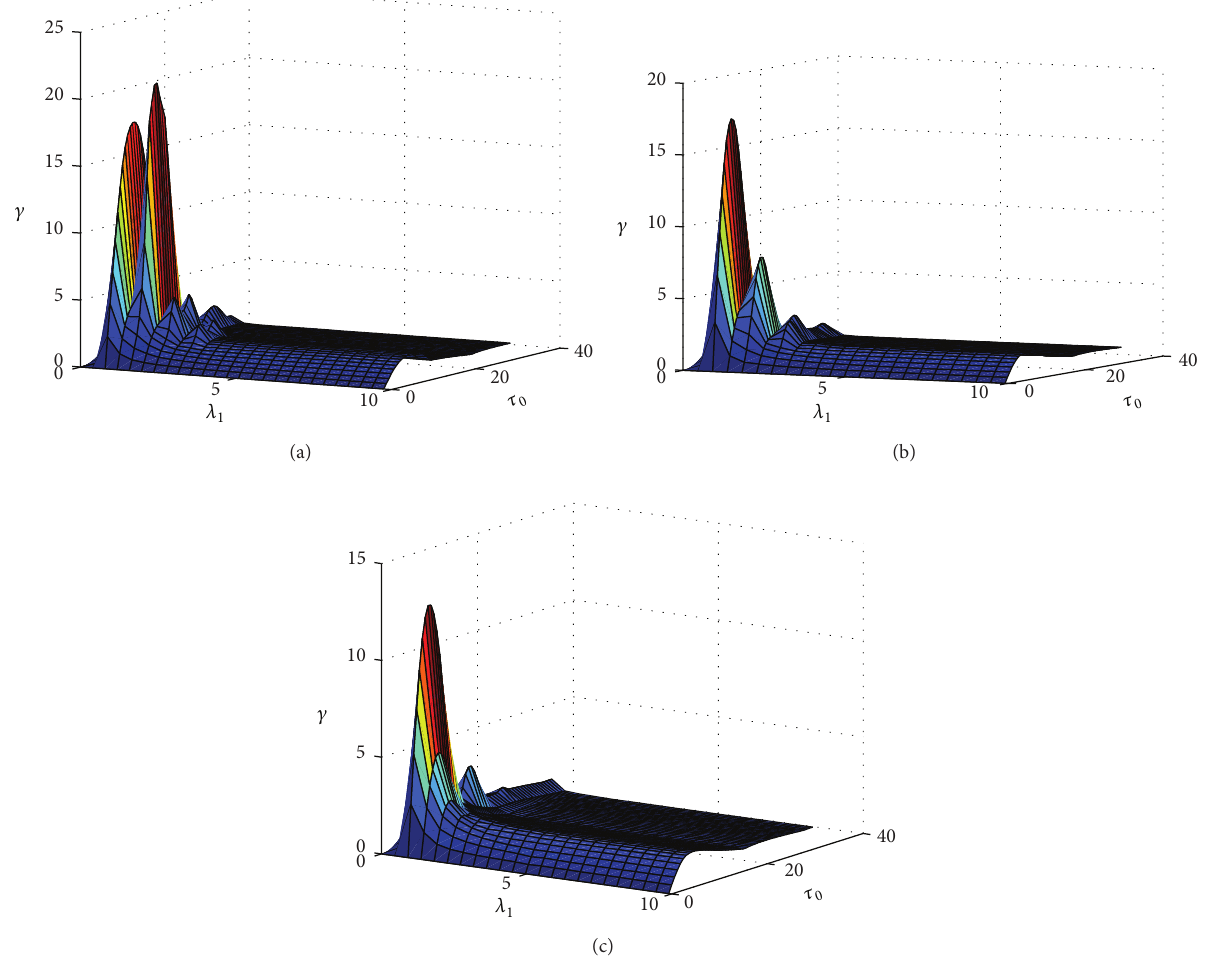
Figure 7: The effect of the angle of the tilted support spring on three-dimensional shock response spectrum of critical components: (a) = 60 ∘ ; (b) 𝜑 = 70 ∘ ; (c) 𝜑 = 90 ∘ 𝜑 0 0 0